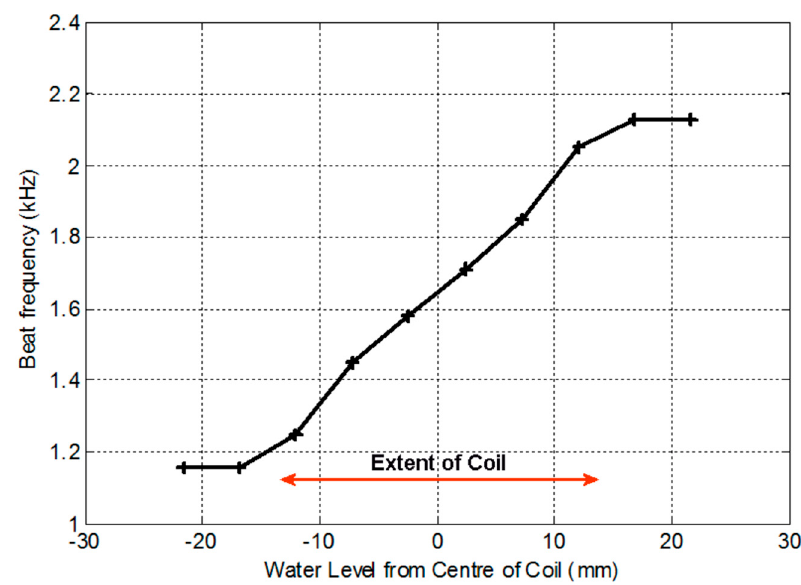
Figure 16. Measured beat frequency as a function of the differential water level.